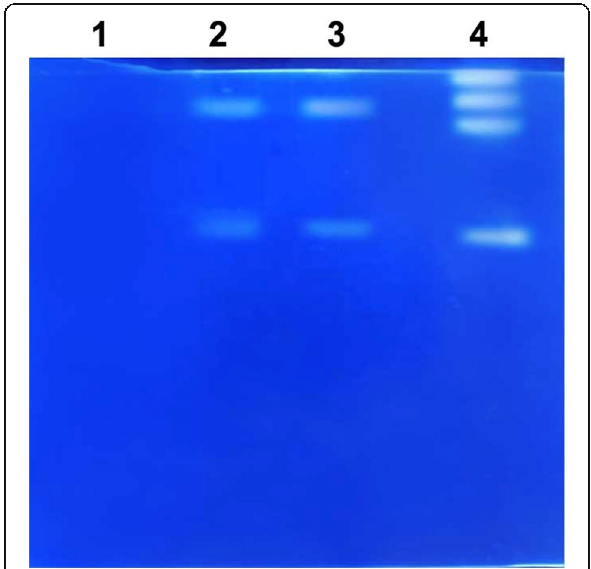
Fig. 4 Zymogram of purified fat body lipase from G. mellonella larvae. 1: Fraction 17 after sephadex G-100 column, 2: Fraction 6 after loading column, 3: Sample after amm. Sulfate percipitation (40 – 80%), 4: Unpurified fat body